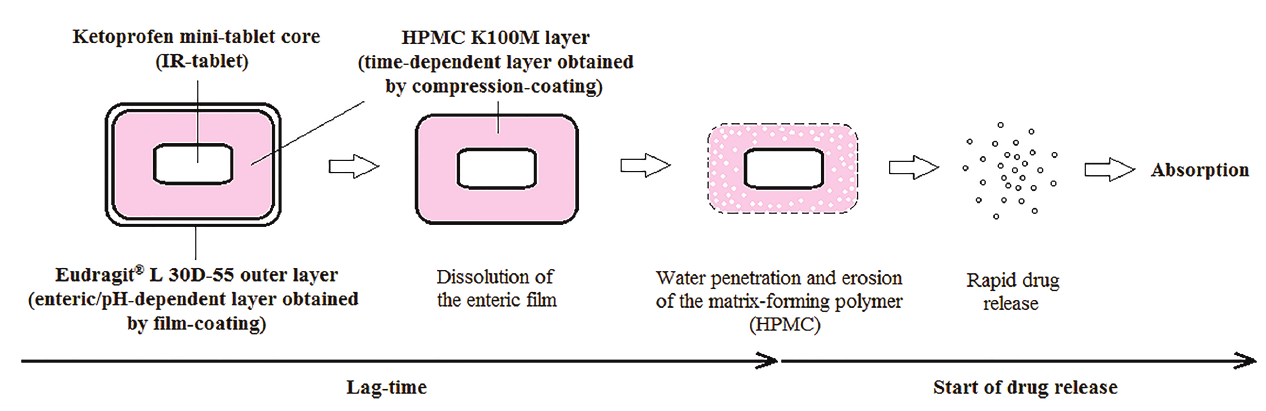
FIGURE 1 – Design of compression-coated tablets for colonic release (CR-tablets) and expected drug release